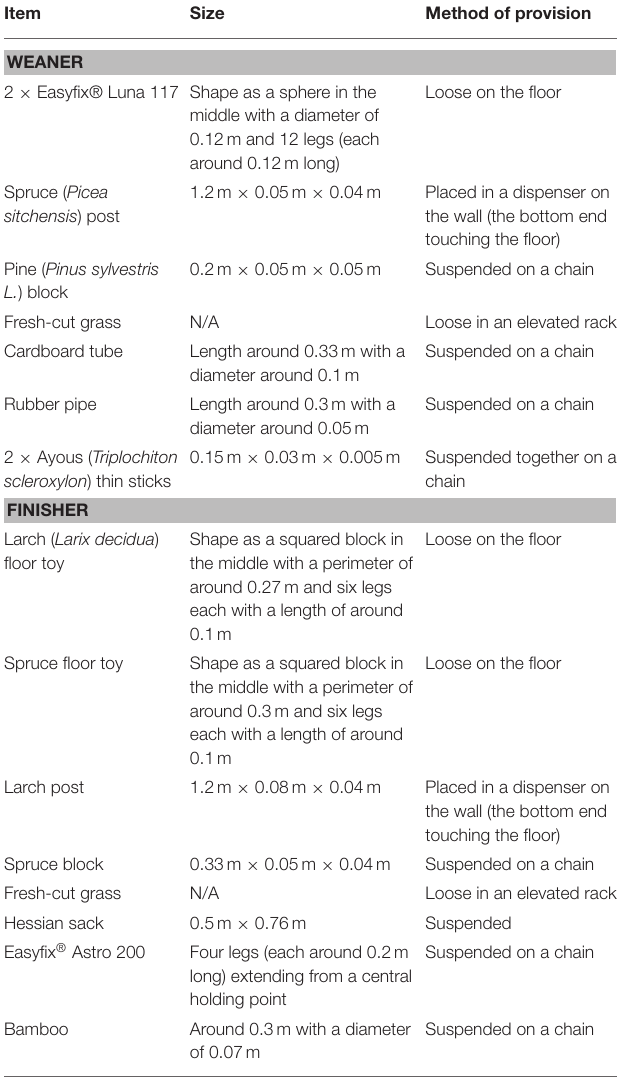
TABLE 2 | The quantity of replenishment of fresh-cut grass provided at each check.